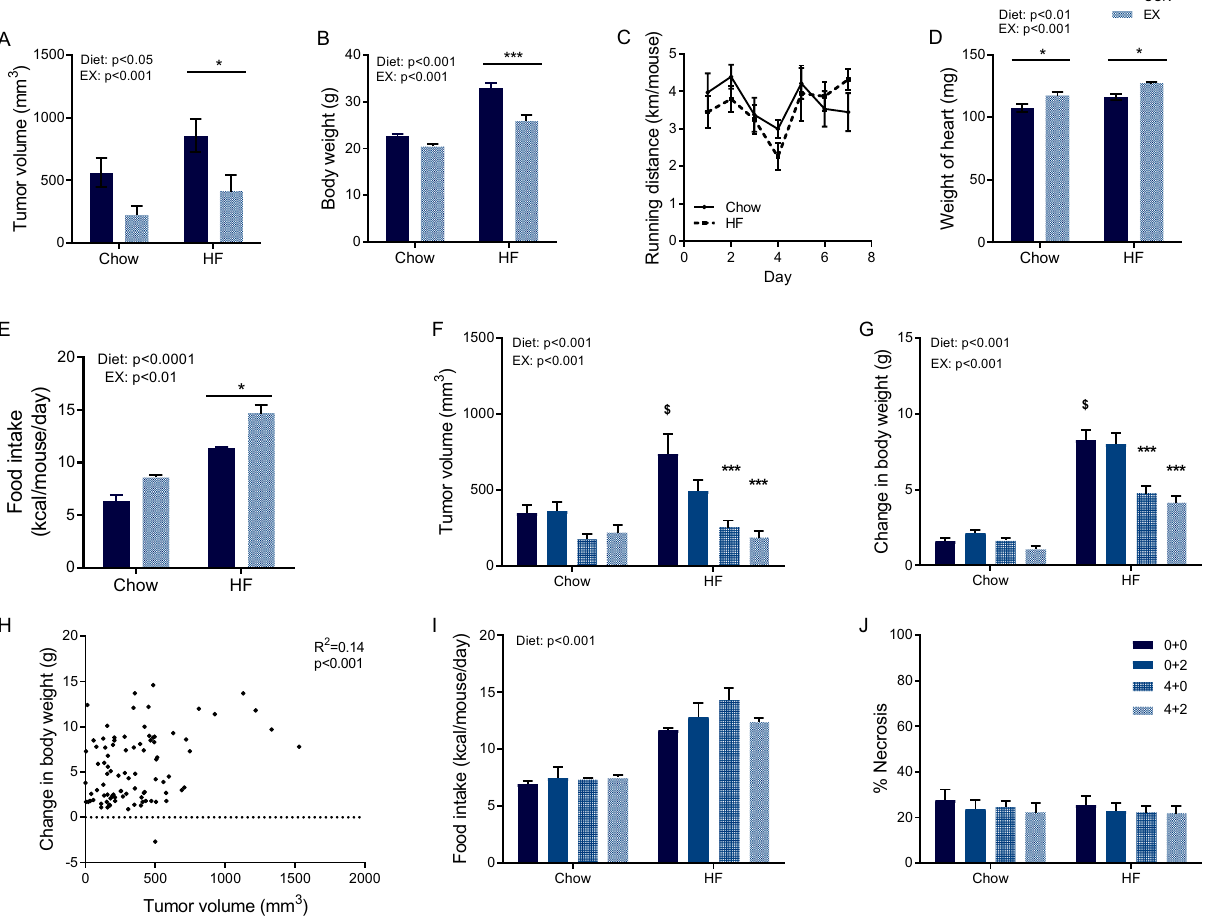
Figure 2. Effect of wheel running on B16 melanoma growth in mice fed chow or high-fat diet. C57bl/6 mice were randomized to cages containing running wheels for 4 weeks prior to tumor inoculation and during tumor challenge (EX) or no running wheel (CON), and further randomized to chow or high-fat feeding (HF) (n = 12, study design 1). In these mice, ( A ) tumor volume, ( B ) body weight, ( C ) running distance, and ( D ) weight of the heart were determined at termination, while ( E ) the average daily food intake was monitored both prior and after tumor induction. In a parallel study (study design 2), mice were randomized to cages containing running wheels for 4 weeks prior to tumor inoculation and during tumor challenge (4 + 2), 4 weeks just prior to tumor inoculation (4 + 0), 2 weeks during tumor challenge (0 + 2), or no running wheel (0 + 0) (n = 12). In these mice, ( F ) tumor volume, ( G ) change in body weight, ( H ) association between tumor volume and change in body weight, ( I ) the average daily food intake (including the period both prior and after tumor induction) and ( J ) percentage of necrotic area in B16 tumors from (2 F ) were determined. Statistical significance was determined by 2-way ANOVA with Tukey’s post hoc test ( A, B, D, E, F, G, I, J ) or linear regression analysis ( H ). P values for diet and EX describe the results of the 2-way ANOVA, while $ indicates statistical significance difference between Chow (0 + 0) and HF (0 + 0) at p < 0.05 and individual stars indicate difference from control (CON/0 + 0) group within each feeding group in the post hoc tests. ** p < 0.01, *** p <